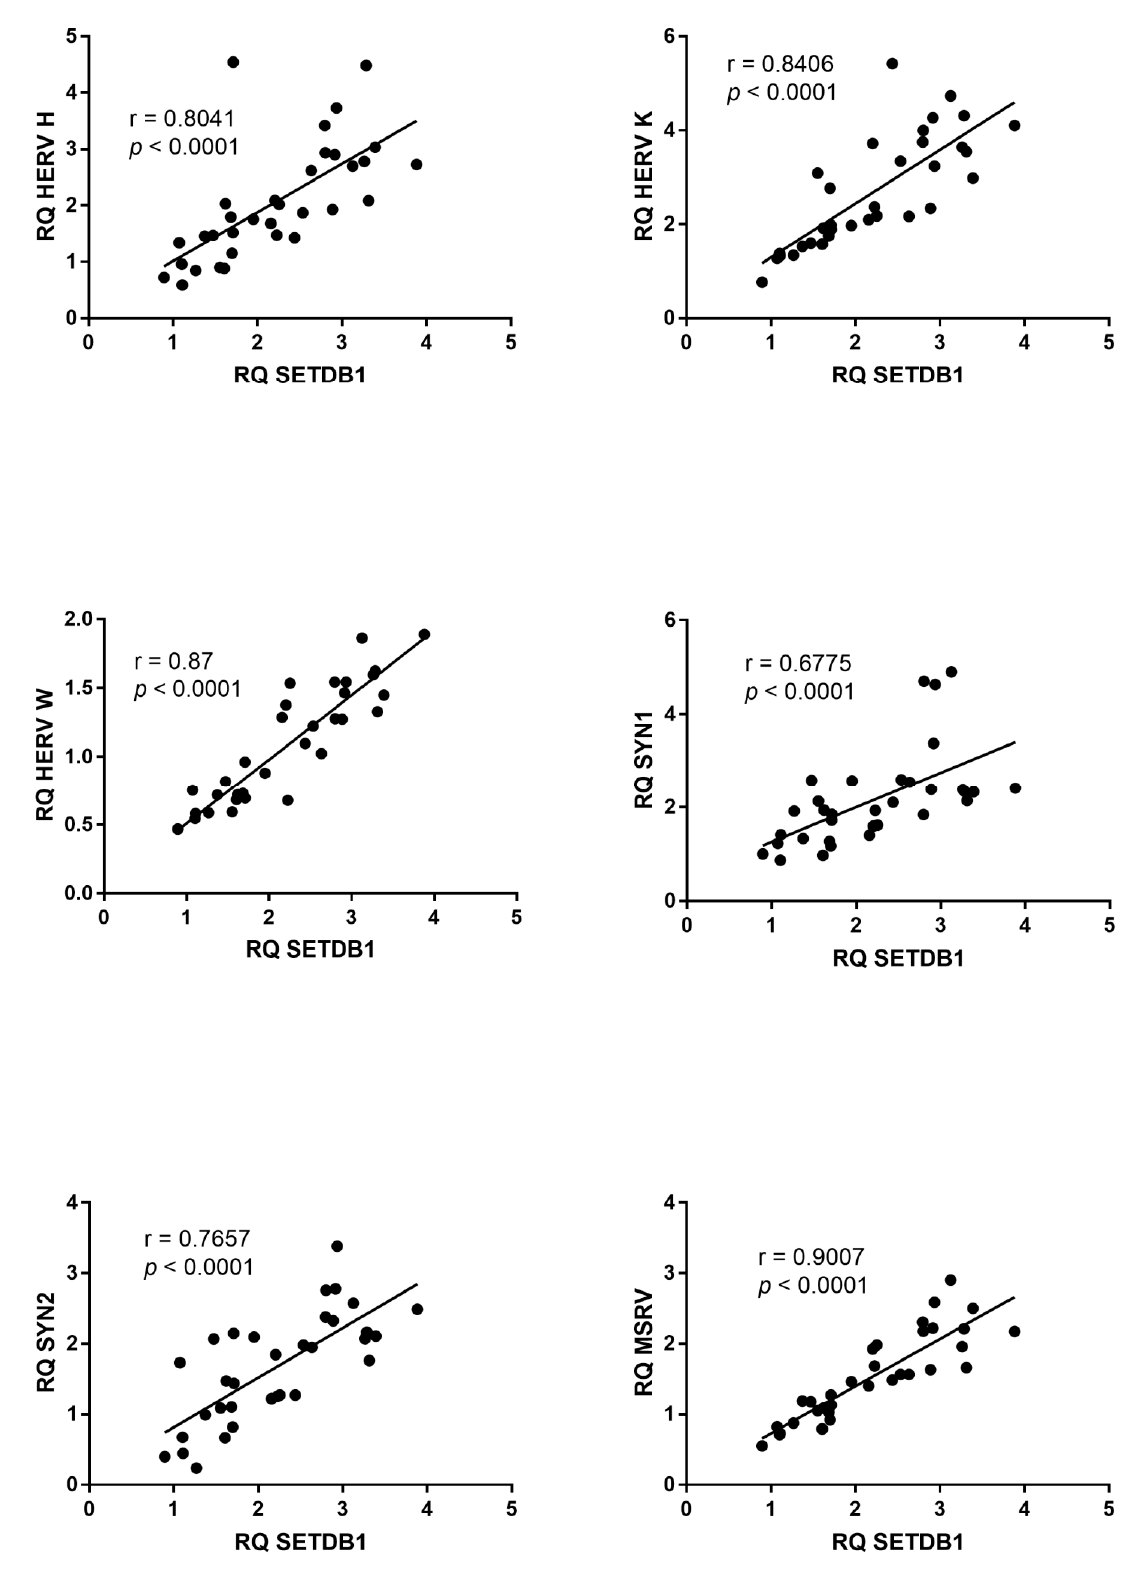
Figure 5. Correlations between transcription levels of SETDB1 and HERV sequences in whole blood from 33 children with ASD. RQ: relative quantification. Circles show the mean of three individual measurements. Line: linear regression line. Statistical analysis: Spearman correlation test.